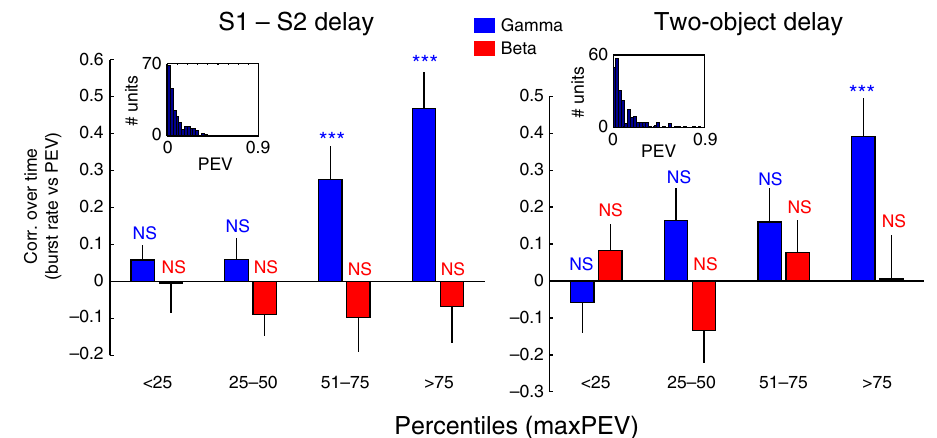
Fig. 4 Temporal correlation of PEV information and burst rates. Correlation between temporal pro fi les of PEV of units with signi fi cant delay information (Methods section) and gamma (blue) and beta (red) burst rates recorded on the same site. The data are broken down into percentiles based on maximal PEV for each unit. In delay 1 (S1 – S2 delay), burst rates were correlated with PEV information about the identity of sample 1 (left); in delay 2 (two-object delay), burst rates were correlated with the sum of PEV information about the identities of both samples 1 and 2 (right). T -test was used with n = 36 in each group. In delay, 1 only top two quantiles for gamma were signi fi cant ( p = 0.005 and 3.2e − 05, respectively); in delay 2, only the top quantile was signi fi cant ( p = 0.001). Error bars correspond to SEM. Inlets show the distribution of peak PEV in each delay for all units with signi fi cant information (Methods